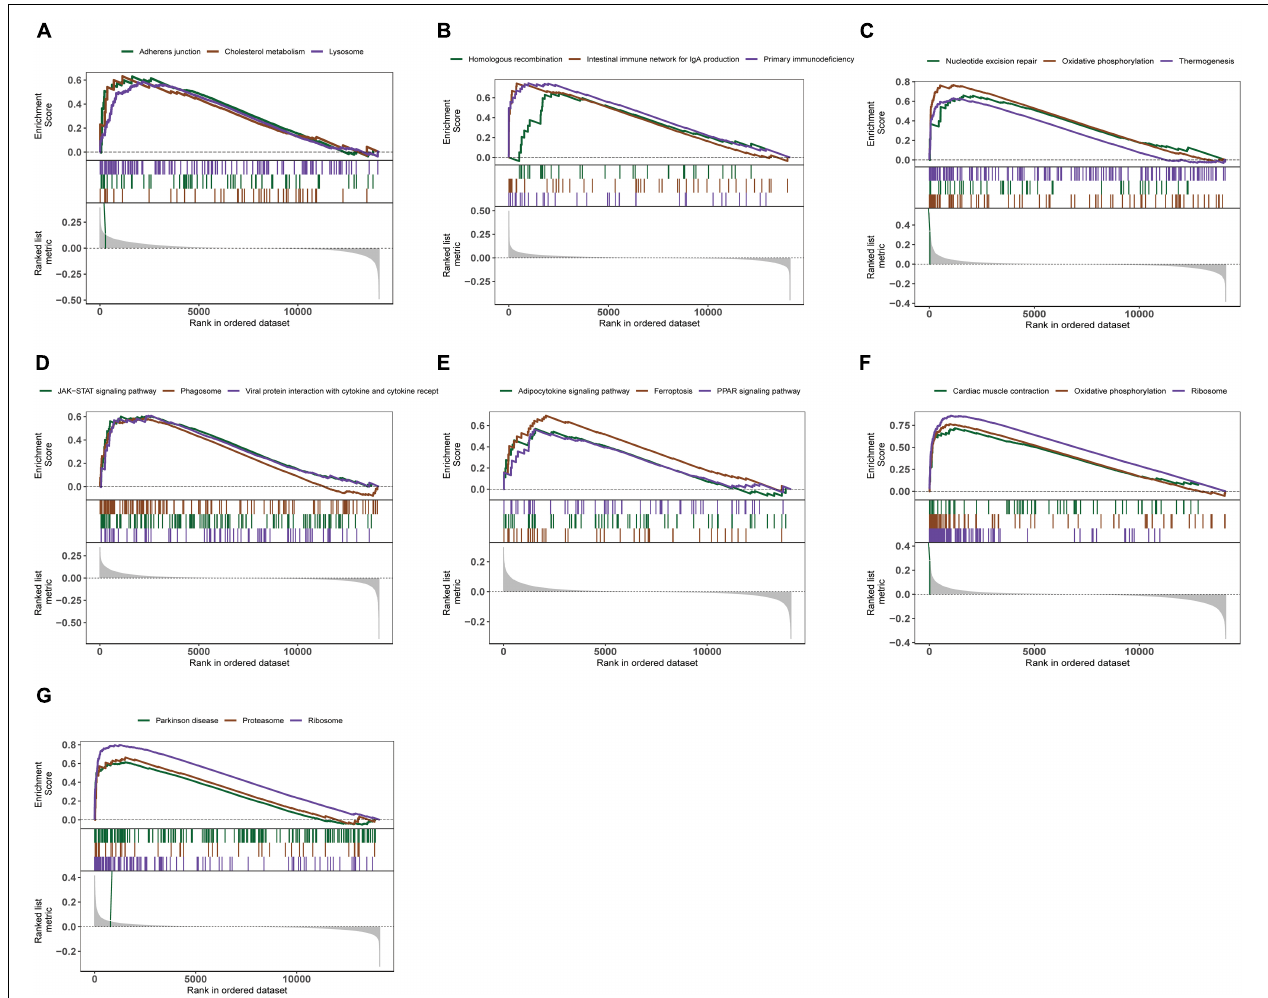
FIGURE 4 | Enrichment analysis of pathway and gene ontology (GO) involved hub genes. (A–G) Gene Set Enrichment Analysis of ABCA2, CREBRF, CD72, CETN2, KCNG1, NDUFA2, and